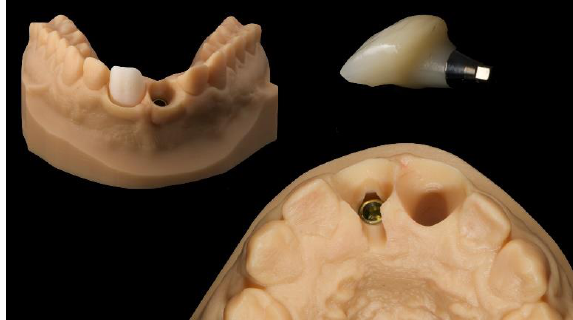
Figure 14. Transition zone showing good soft-tissue healing.